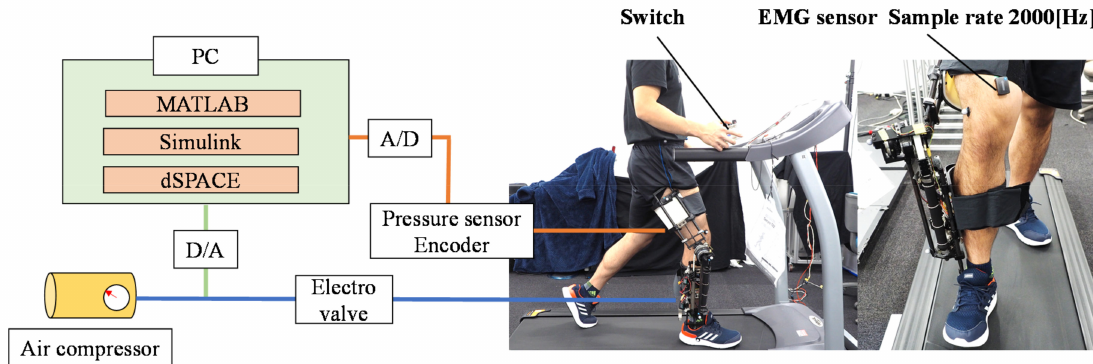
Figure 13. Experimental environment in assist evaluation of the gait motion.